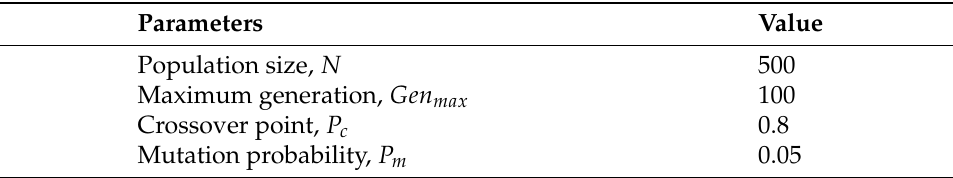
Table 2. GA setup